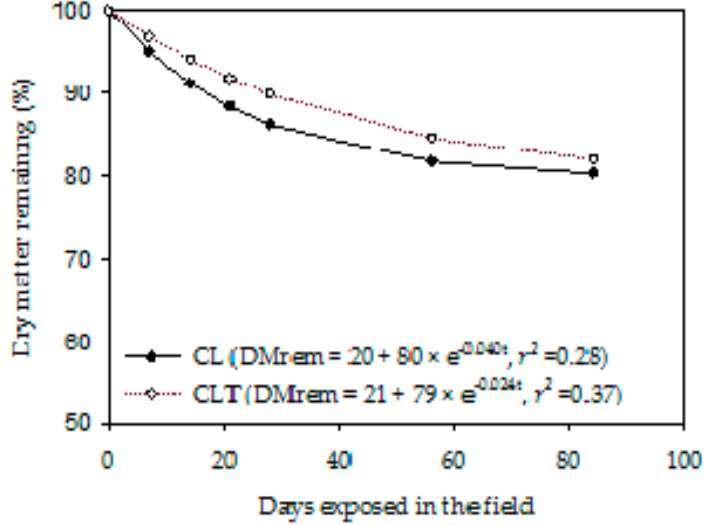
Figure 5. Dry matter remaining (%) from the cattle dung residue, during exposure into the pasture (i.e., Lolium multiflorum + Avena strigosa ) as affected by the systems (CL, crop–livestock and CLT, crop–livestock–tree). Dry matter or N, P, K and S remaining (rem) = res + act e − kt . res , resistant fraction;